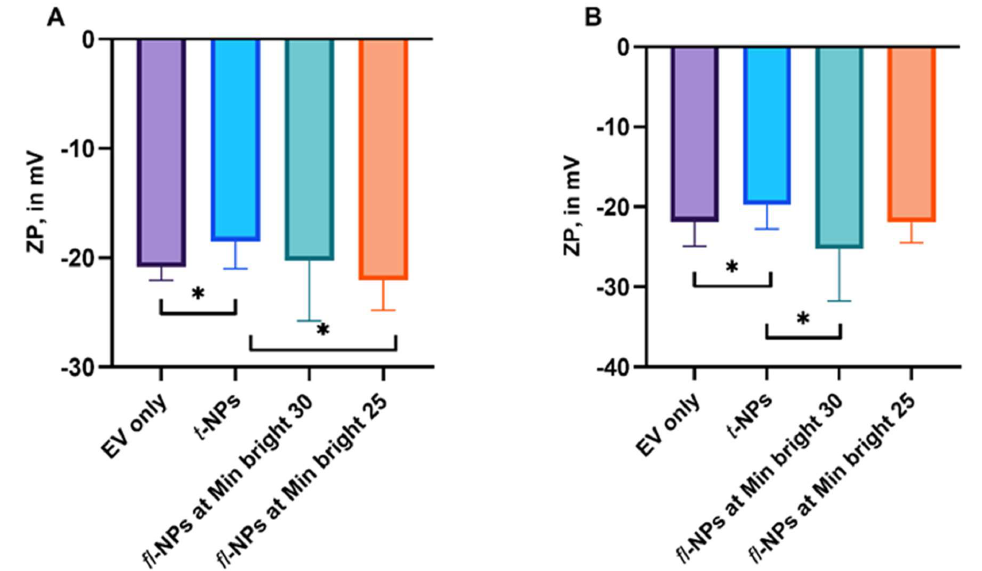
Figure 3. ZP measurement of total and fluorescent NPs for JAr and HCT 116 EVs labeled with CMG dye. The ZP for EVs only control (light purple boxes), CMG-labeled fluorescent (cyanish-green and orange boxes) and total NPs (light blue boxes) of JAr ( A ) and HCT 116 EVs ( B ) measured in the fluorescent and scattered mode of NTA at two different minimum brightness threshold levels. The ZP values of fl- NPs originating from JAr and HCT116 cells measured at minimum brightness threshold of 25 and 30 were significantly different ( p ≤ 0.05) than the respective t -NPs originating from JAr and HCT116 cells, thus were marked with an asterisk (*) symbol. EVs were diluted in 1x PBS, and the ZP measurement was done at a neutral pH of 7.2 (mean ± SD, n = 9).